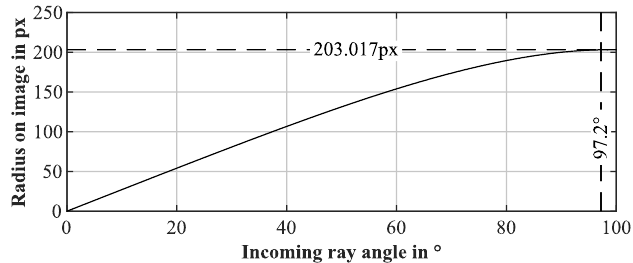
Figure 9. Forward Projection function derived from calibration.